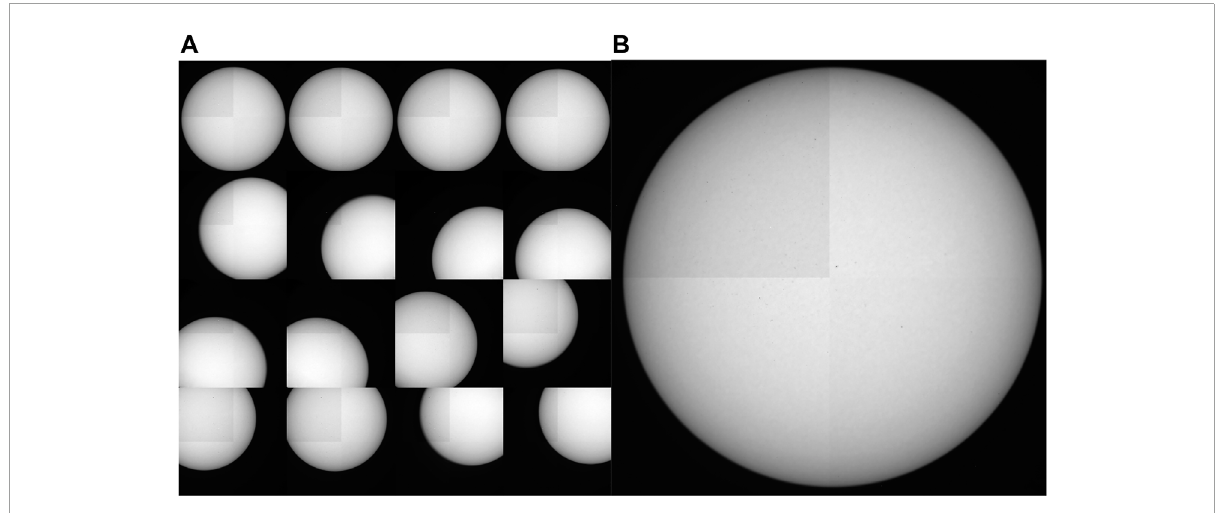
FIGURE 5 Examples of the set of displaced images (A) , each sum of 10 exposures, obtained for the flat-field calibration of the Rome/PSPT blue continuum observations taken on 27th April 2018 and reference image (B) , sum of 25 exposures, centred on the CCD device. The images in the two panels are shown with different size for the sake of ease. The slightly different gain of the four amplifiers employed to read the CCD detector is easily noticed in all the images.